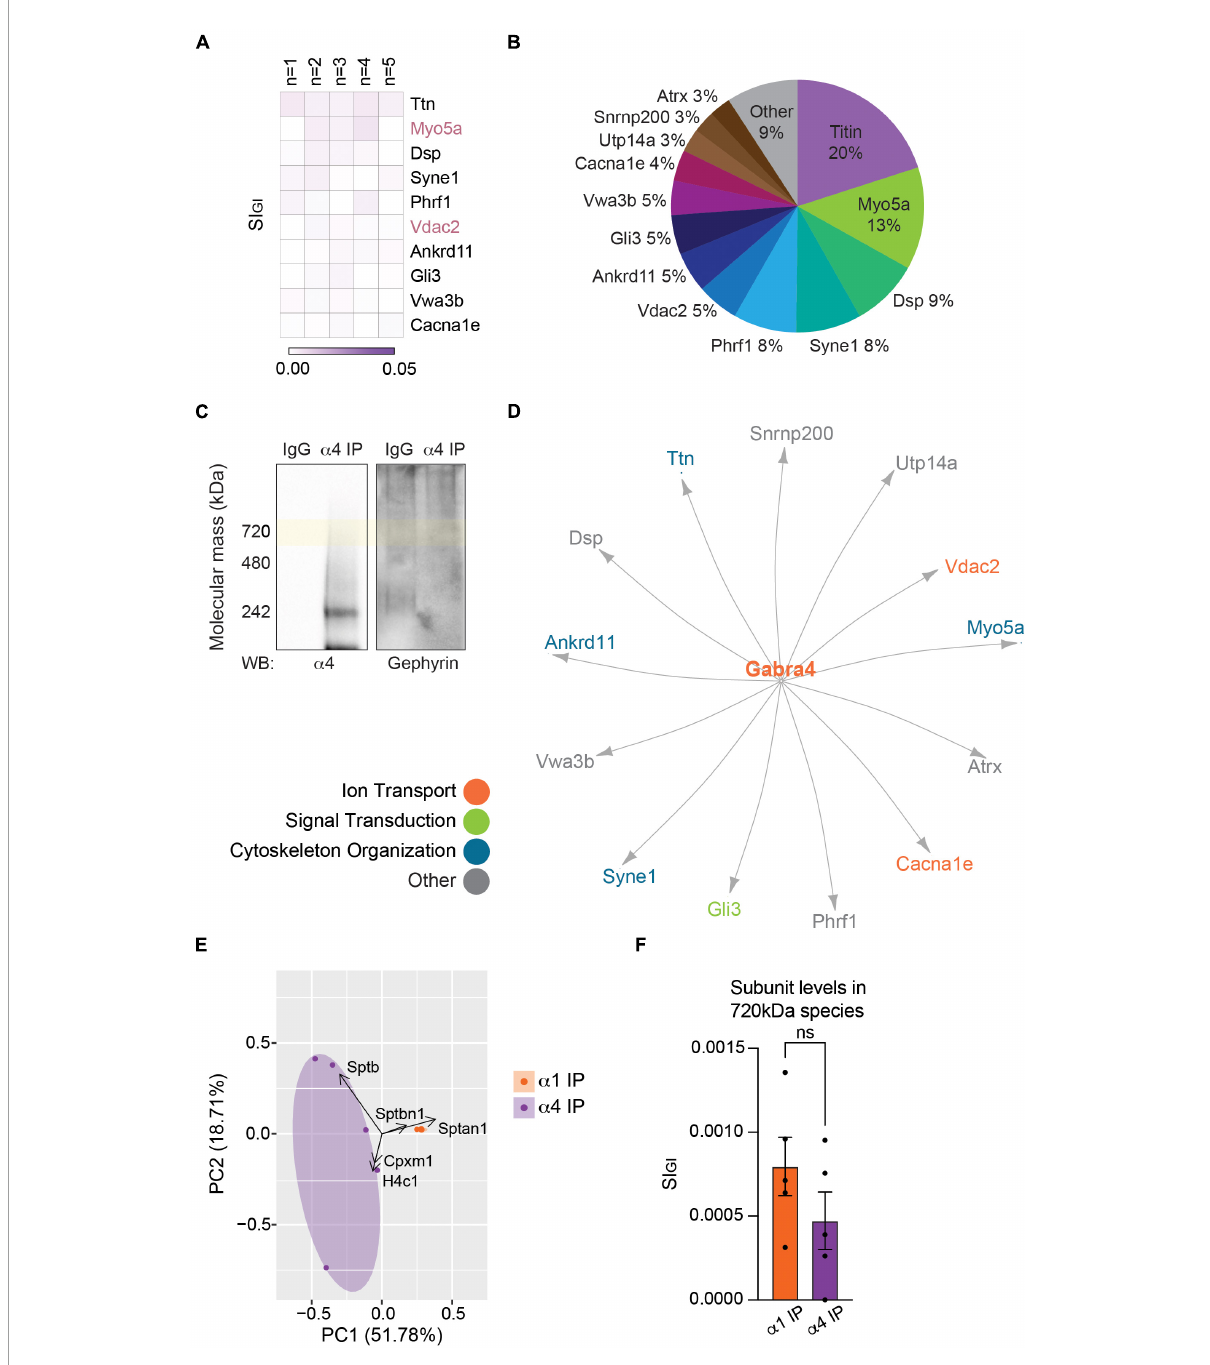
FIGURE3 The endogenous α 4 subunit does not interact with inhibitory scaffolding proteins. (A) Analysis of the 720 kDa band of α 4-containing GABA A Rs with LC-MS/MS and quantitative analysis identified 19 binding proteins. The heatmap shows the top 10 binding proteins by abundance, which include Ttn (titin), Myo5a, and Dsp (desmoplakin). Myo5a and Vdac2 were detected with both the α 1 and α 4 subtypes ( n = 5 replicates). (B) The relative abundance of binding proteins of the α 4 subunit is illustrated as a pie chart. Besides 20% by titin and 13% by Myo5a, most proteins constitute less than 10% of the total amount of proteins detected with α 4-containing GABA A Rs. Proteins that make up less than 2% each (6 proteins) were grouped together as ‘Other.’ (C) BN-PAGE blots of purified α 4-containing GABA A Rs show the absence of gephyrin in the α 4 subtype. (D) The network analysis reveals no known interactions among the proteins detected with the α 4 subunit. (E) PCA plot of the significantly enriched binding proteins of the α 1 and α 4 subunits show high reproducibility of datasets between replicates. It also highlights the difference in the binding proteins of the two receptor subtypes. (F) Target subunit recovery in 720 kDa bands between subtype purifications is comparable (ns ≥ 0.05, n = 5